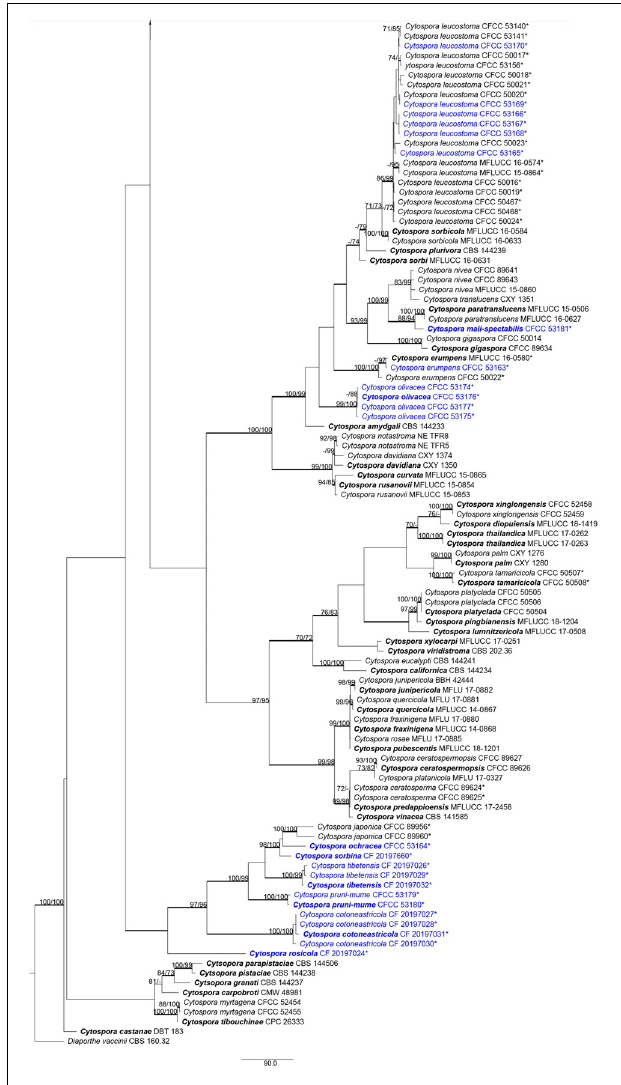
FIGURE 3 | Phylogram of Cytospora based on combined internal transcribed spacer (ITS), large nuclear ribosomal RNA subunit (LSU), actin ( act ), RNA polymerase II subunit ( rpb2 ), translation elongation factor 1- α ( tef1- α ), and beta-tubulin ( tub2 ) genes. Maximum parsimony (MP) and maximum likelihood (ML) bootstrap support values above 70% are shown at the first and second positions. Thickened branches represent posterior probabilities above 0.95 from Bayesian inference (BI). Ex-type strains are in bold. Strains in current study are in blue. All the Cytospora species listed from Rosaceae plants in China are marked with